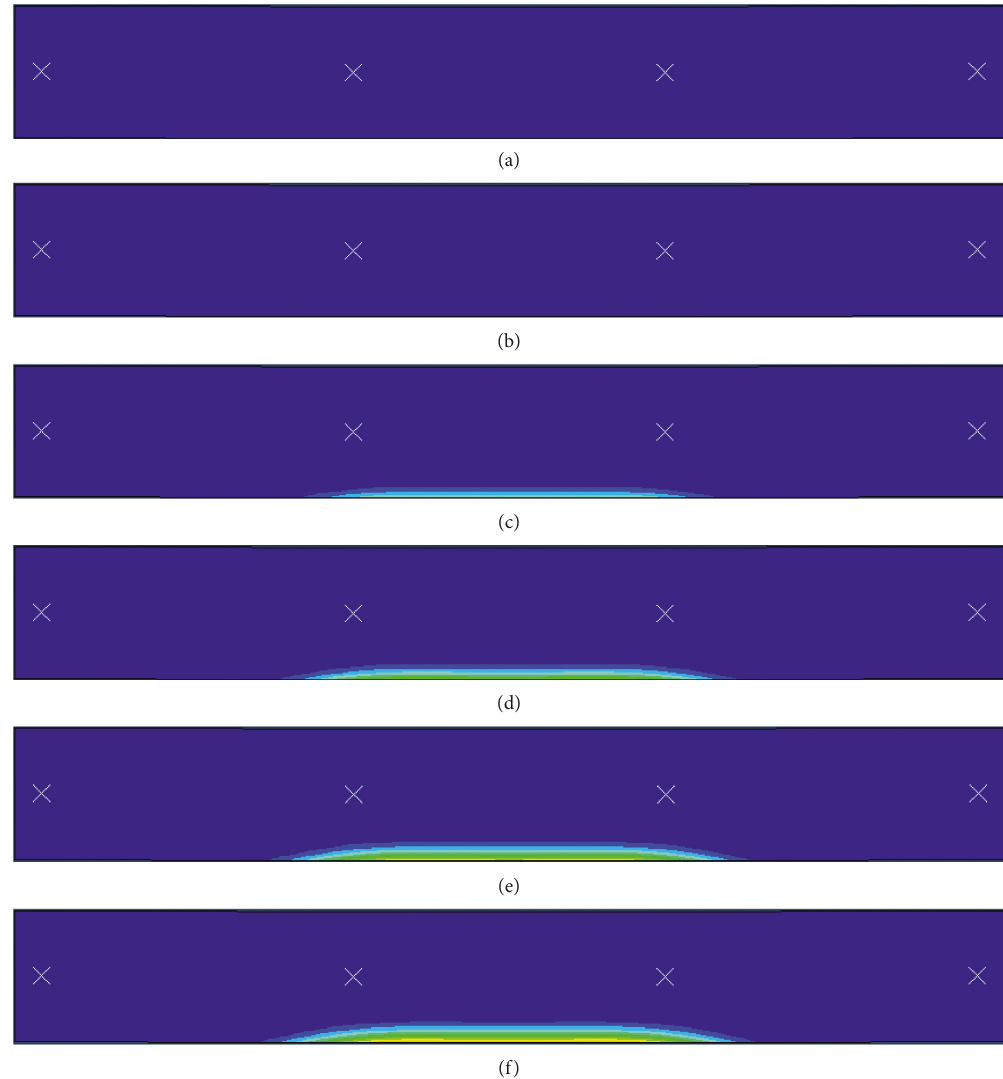
Figure 11: Damage evolution of asphalt mortar with load cycles. (a) Load cycles N � 200, D 5.492 e − 3; (c) load cycles N � 20000, D 1.137 e − 1; (f) load cycles N � 77600, D